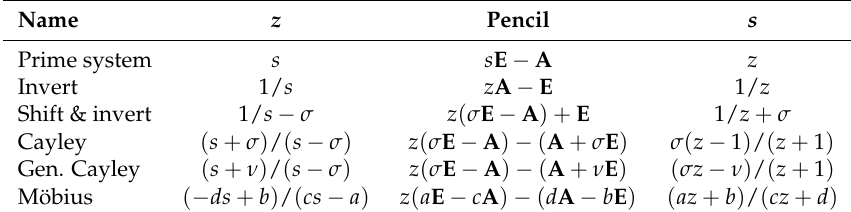
Table 1. Common linear spectral transforms.